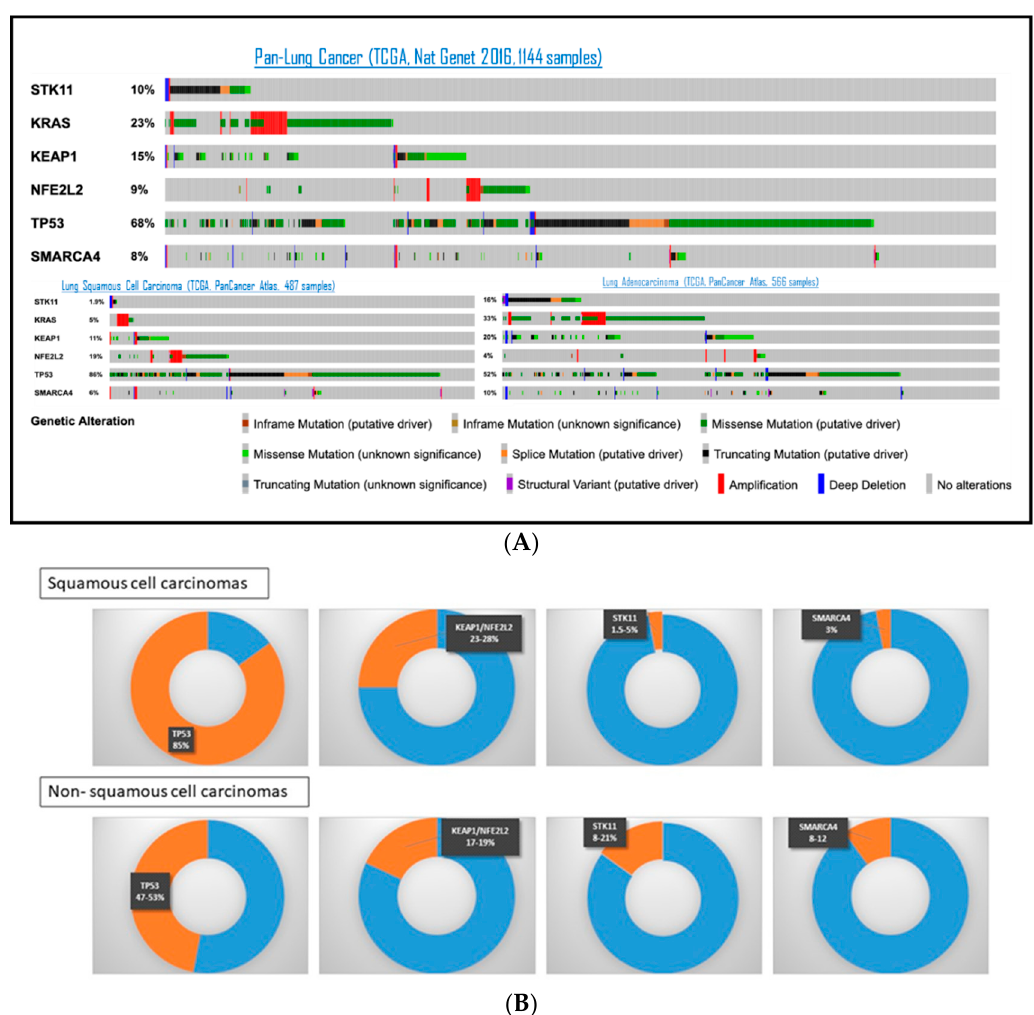
Figure 2. Frequency of most common genomic alterations in tumor suppressor genes among NSCLC patients, based on TCGA ( A ) and the literature ( B ) Panel ( A ) is adapted from https://www.cbioportal.org/ (accessed on 1 October 2021)